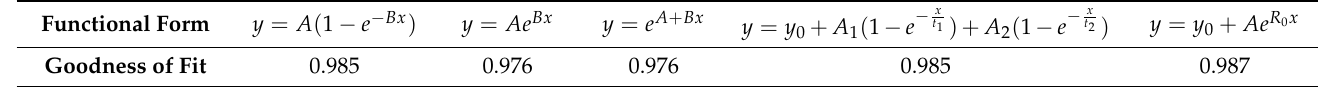
Table 6. Average fitting error of different fitting